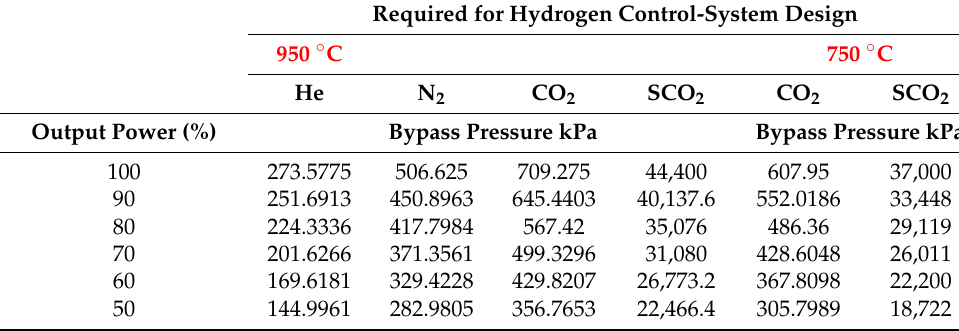
Table 2. Hydrogen-valve offtake pressures (kPa).